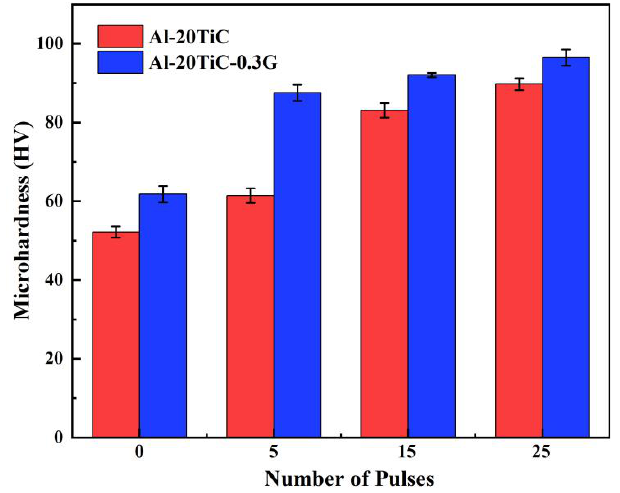
Figure 9. Changes in microhardness of electron beam treated aluminum matrix composite surfaces before and after the addition of graphene.